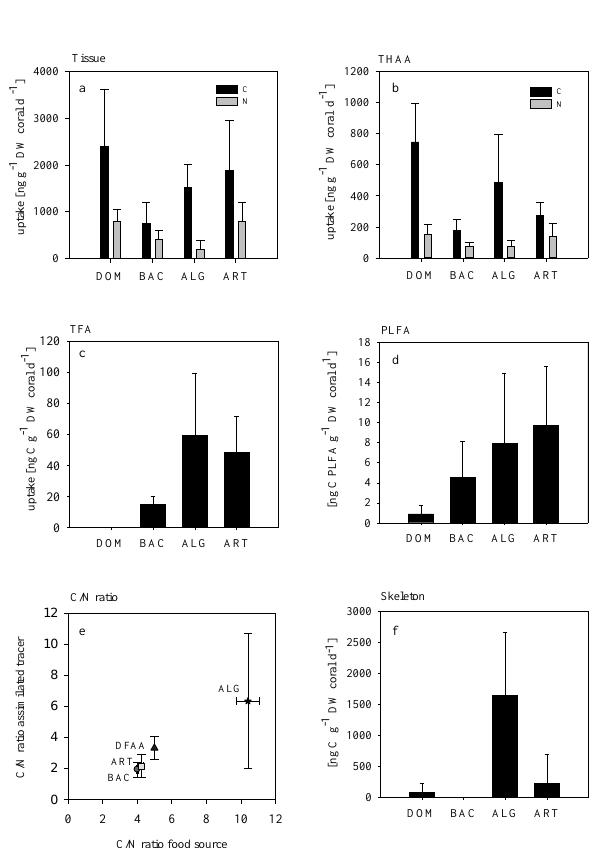
Fig. 3. (a) C and N uptake in coral tissue (note: different C/N ratios of sources), (b) C and N uptake in THAAs of coral samples (note: different C/N ratios of sources), (c) C uptake in TFAs of coral sam- ples, (d) C uptake in PLFAs of coral samples, (e) C/N ratio of food provided and of assimilation, (f) C uptake in coral skeleton. The bars in each figure represent average ±